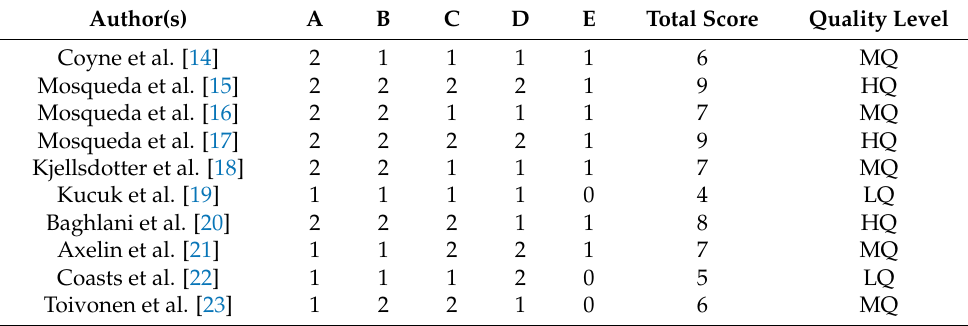
Table 2. List of included studies with quality